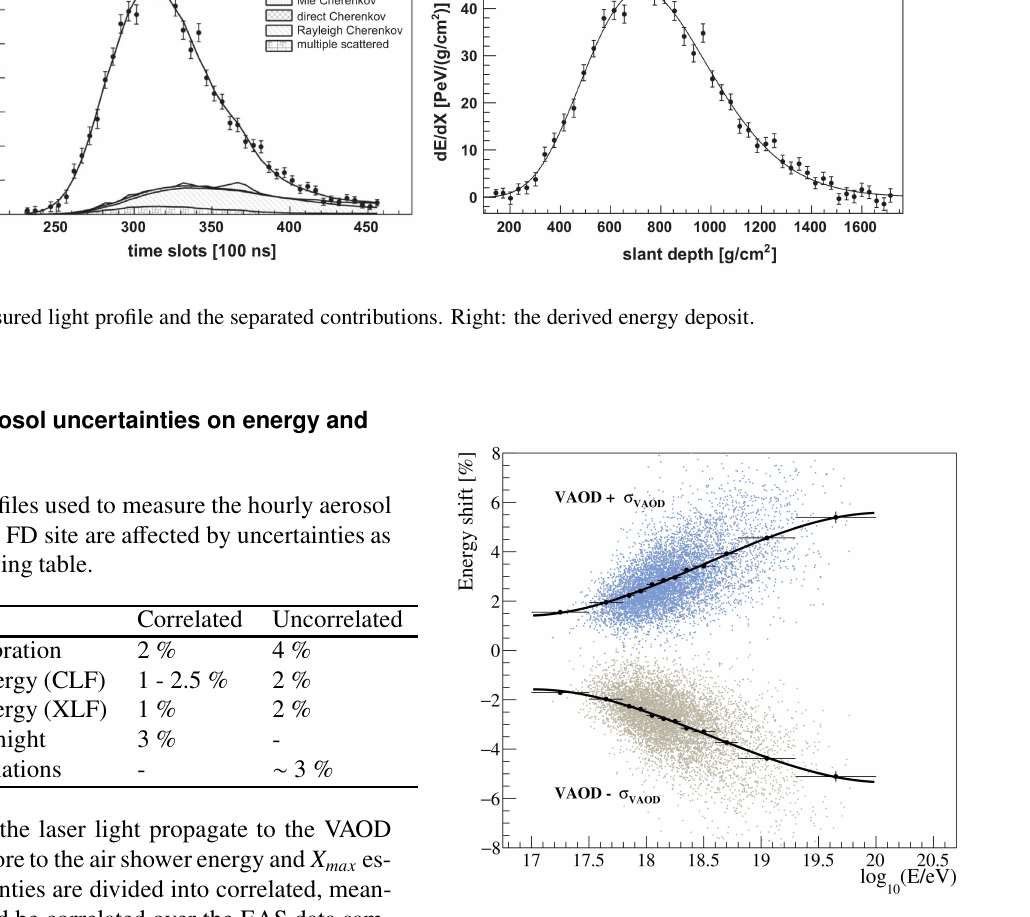
Figure 8. VAOD correlated uncertainty propagated to the air shower energy estimation.